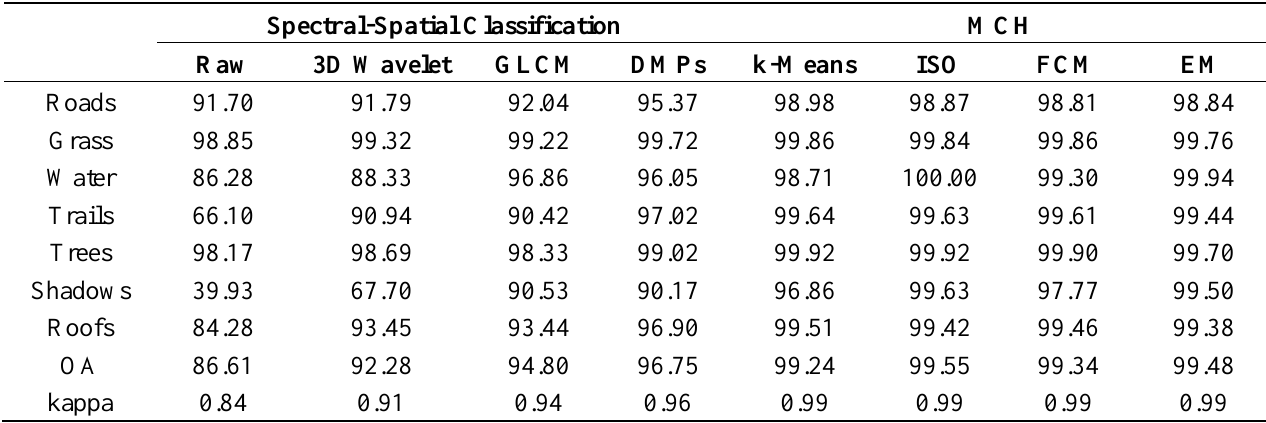
Table 6. Classification accuracies of the different features for the Washington DC image.